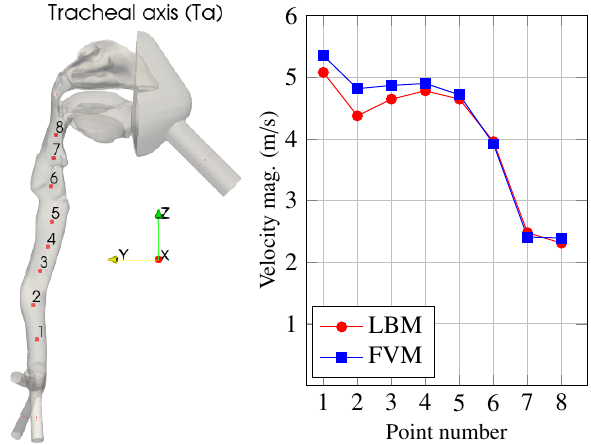
Fig. 6. Comparison of velocity fields at the investigated positions on the axis of